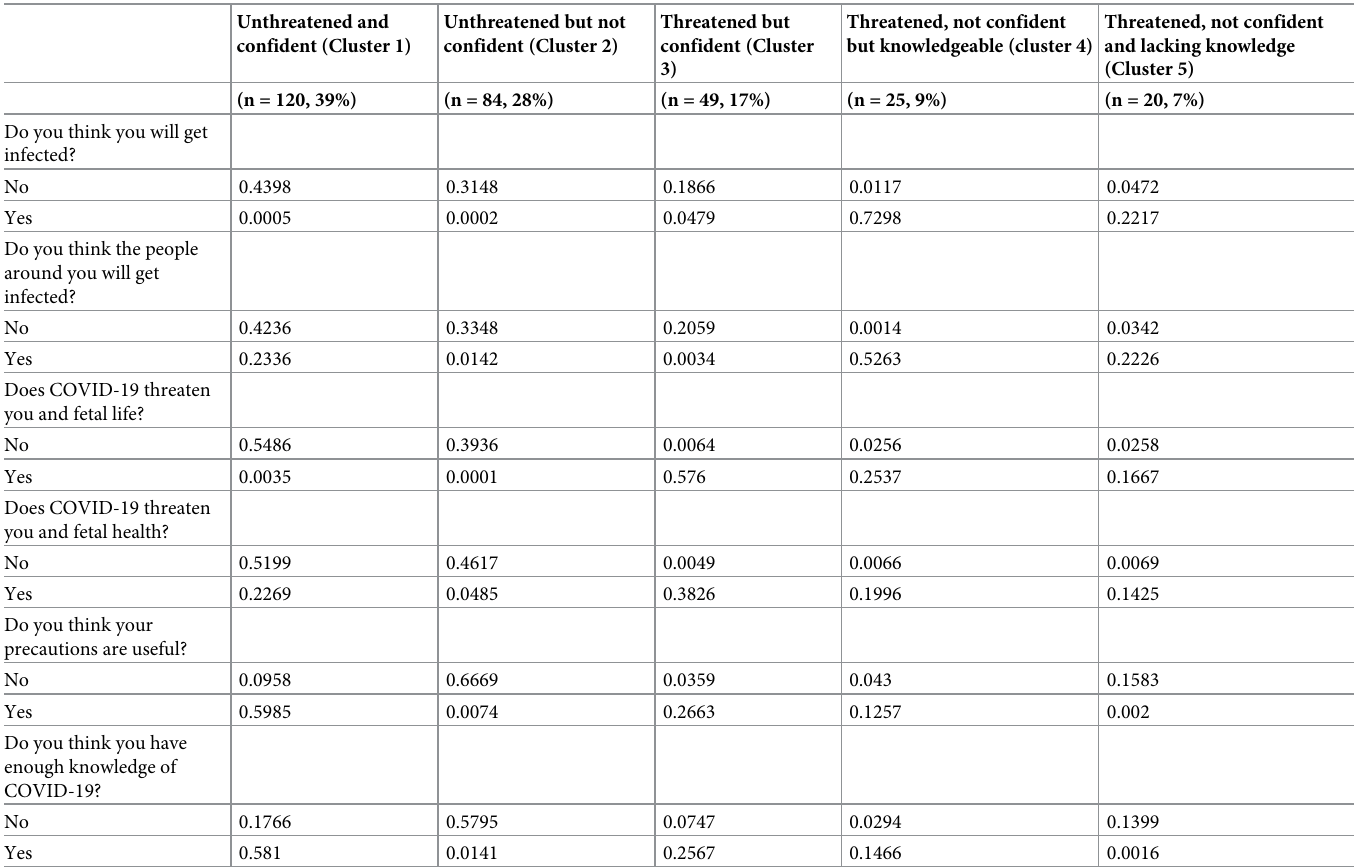
Table 3. The probabilities of choosing six variables by five latent